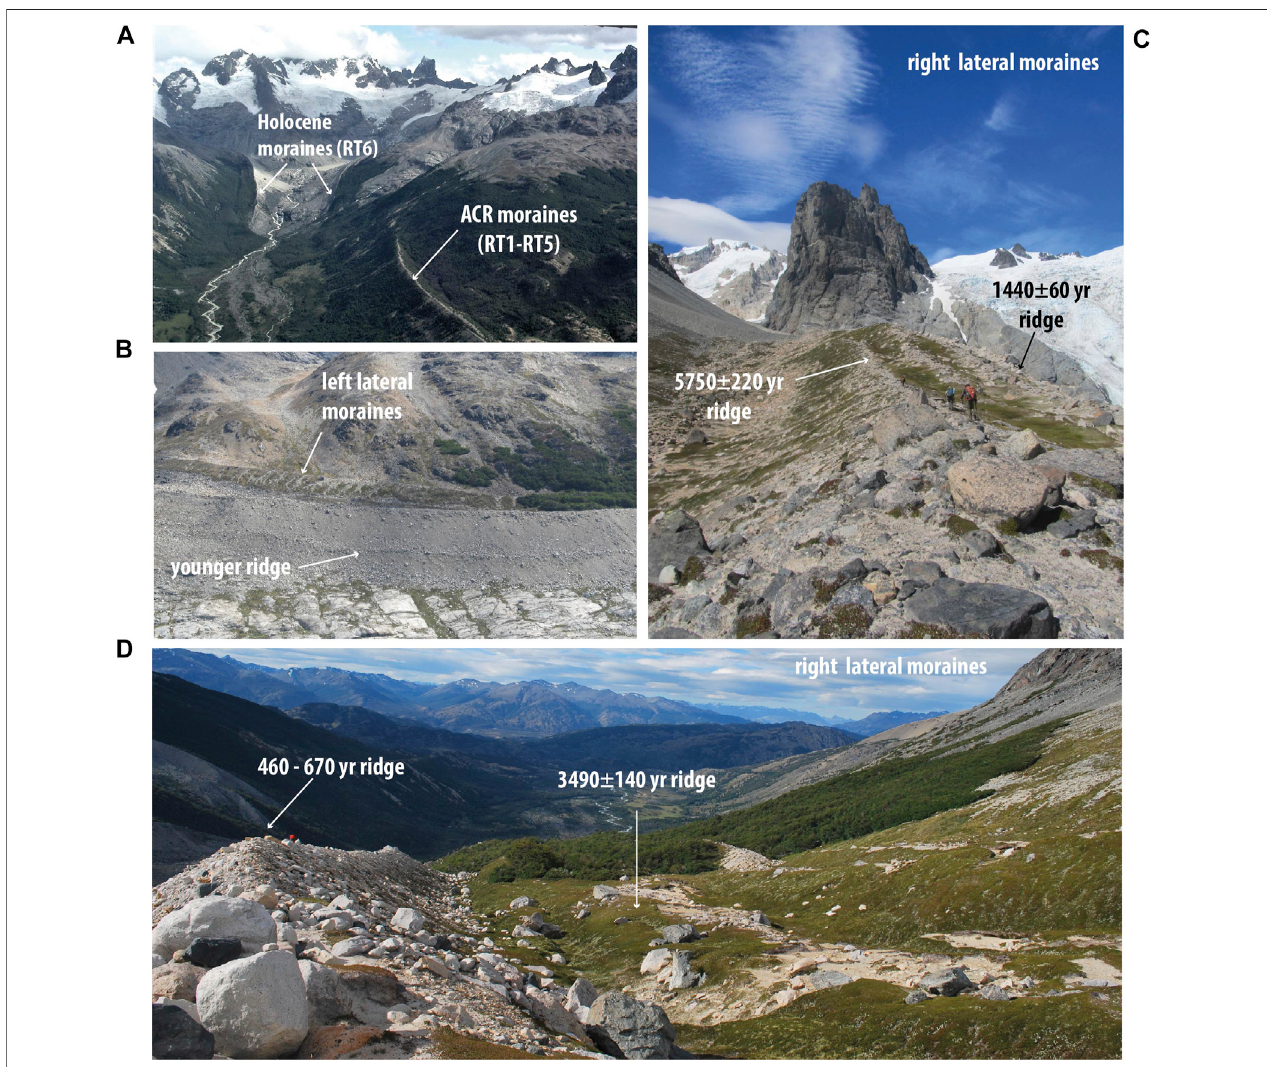
FIGURE2| PhotographsofthemorainesandsettingsintheRíoTranquilovalley. (A) Lateglacial(RT1-RT5)andHolocene(RT6)moraines.Notethedifferenceinthe magnitude between the glacier advances (Photo: Horacio Parraguez). (B) Left lateral moraines. Along the proximal slope it is possible to fi nd remnants of younger recessionalridges. (C) Rightlateralmoraines(facingupstream).Inthissector,the ∼ 3,500 yearsridgewasover-printedbytheyoungermoraine. (D) Rightlateralmoraines (facing downstream). Note the difference in appearance between the younger and older ridges.